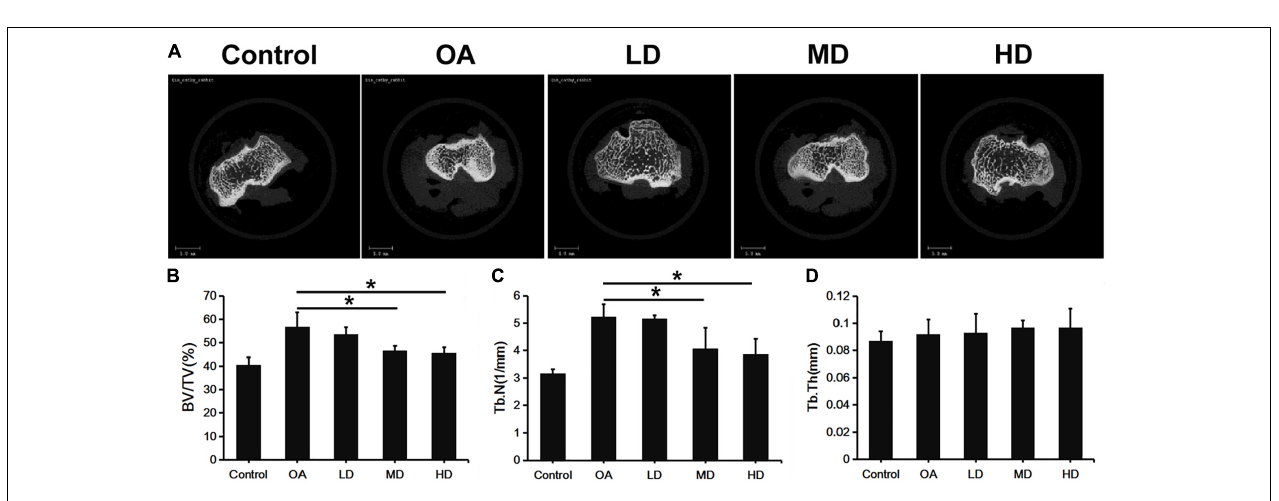
FIGURE 2 | Micro-CT analysis of proximal tibia of difference groups at 8 weeks after surgery. (A) Representative Micro-CT 3D images showed bone microarchitecture of proximal tibia of different groups. Scale bar = 5 mm. (B–D) Quantification of BV/TV, Tb.N, and Tb.Th of different groups. * P < 0.05.